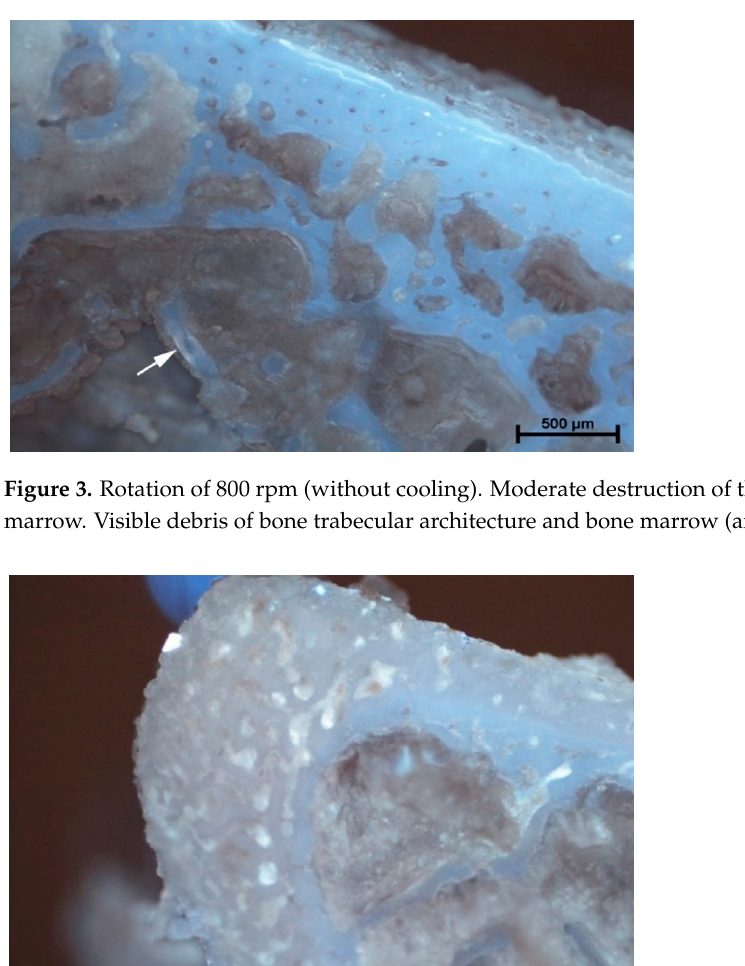
Figure 2. Rotation of 800 rpm (3 °C). The apical area of rib filled with connective tissue. Visible area of tissue compression caused by the drill (arrow).